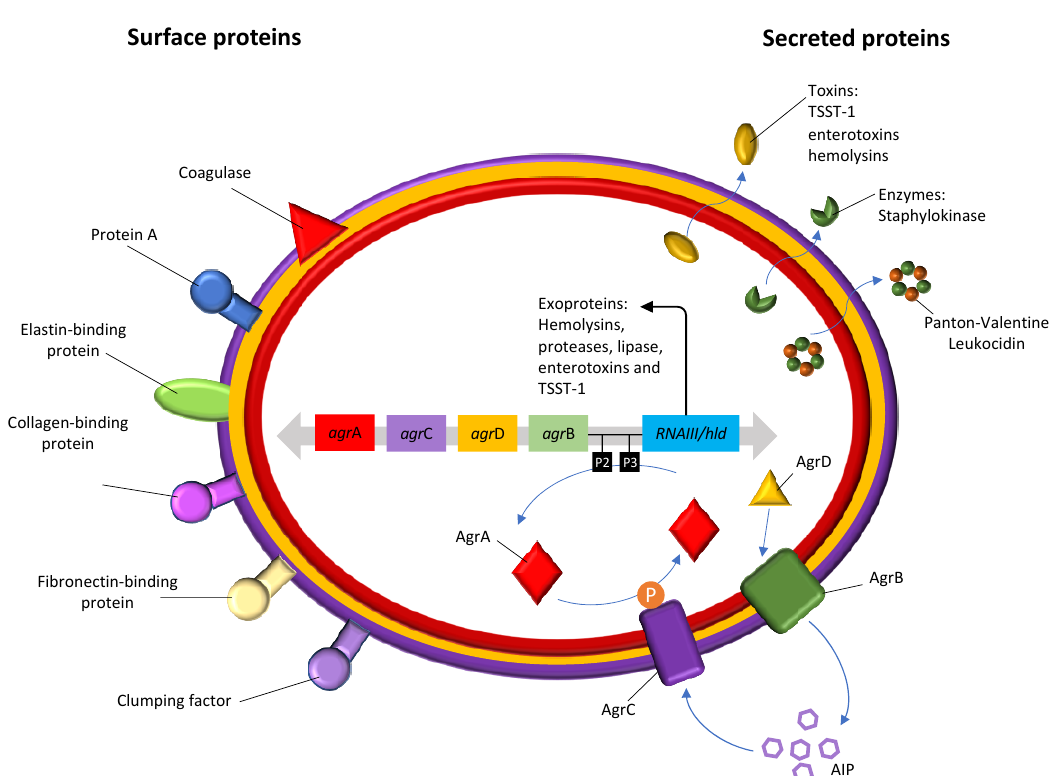
Figure 1. Regulation of virulence determinants in S. aureus .